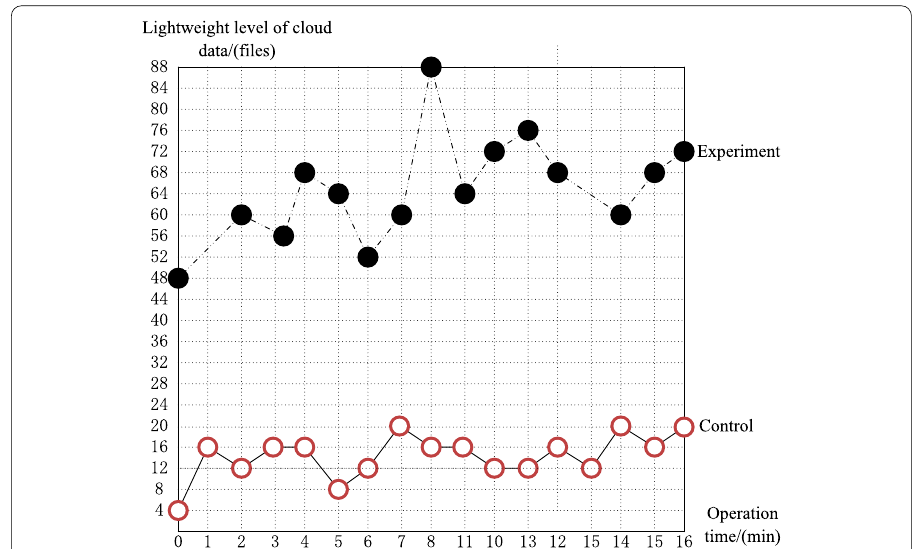
Fig. 7 Comparison of lightweight levels of cloud data (operating status at high mechanical